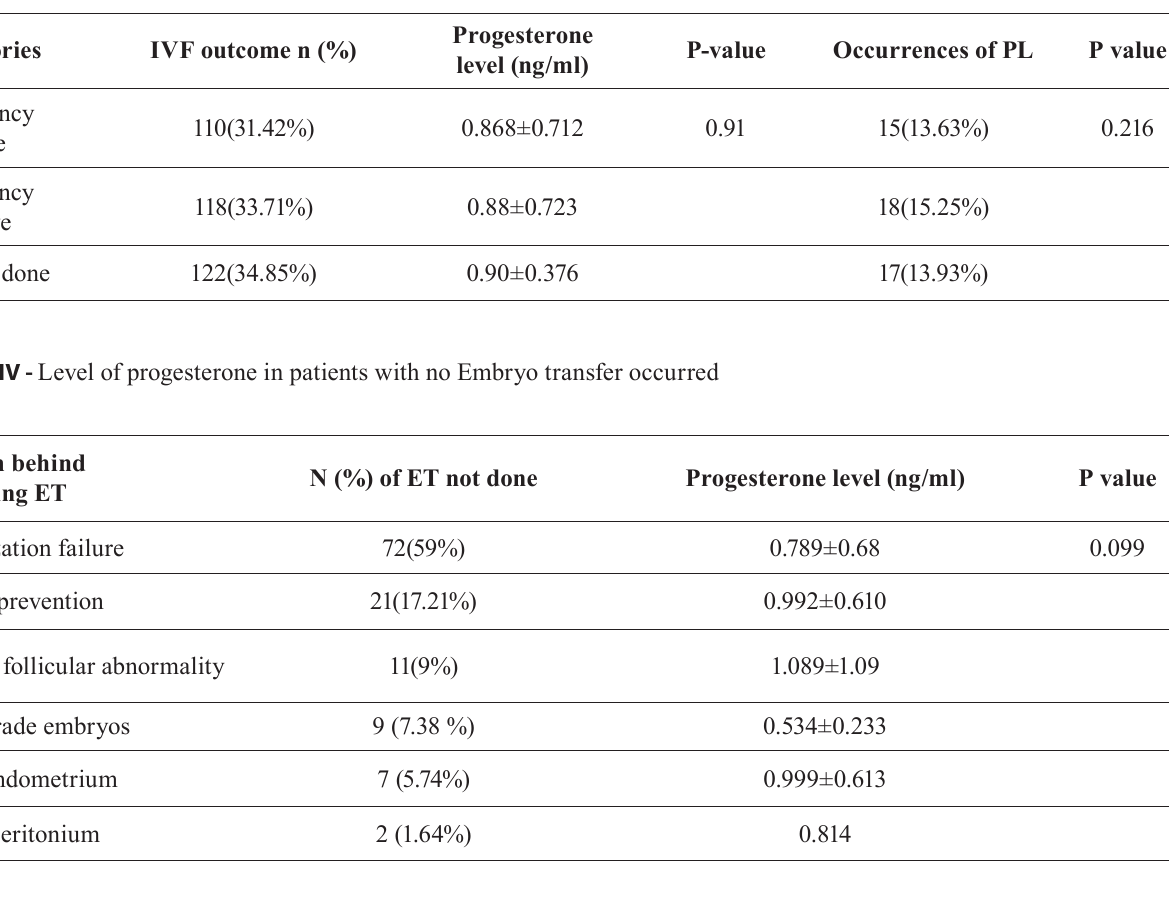
TABLE III - Observed changes in in-vitro fertilization and embryo transfer, premature lutenization occurrence on the day of